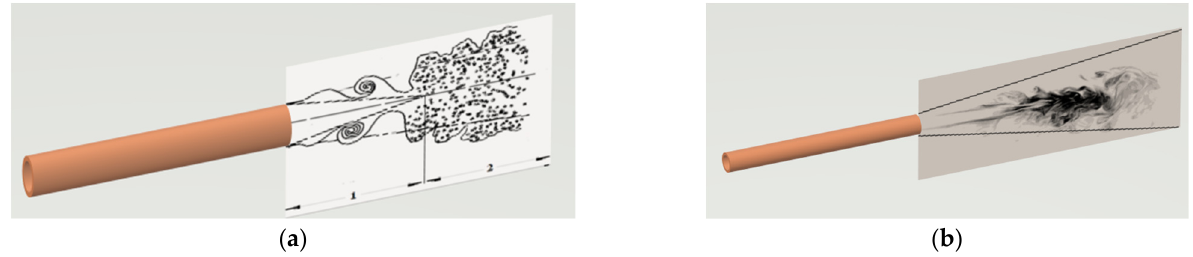
Figure 8. Two jet flow stages in the laminar-turbulent transition regime: ( a ) the “laminar” stage, ( b ) the “turbulent” stage.